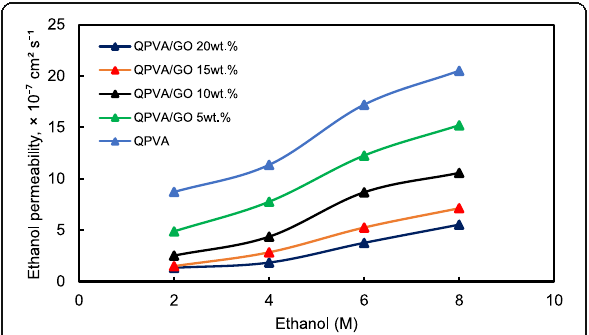
Fig. 15 Ethanol permeability of QPVA/GO 15 wt.% composite membrane with different